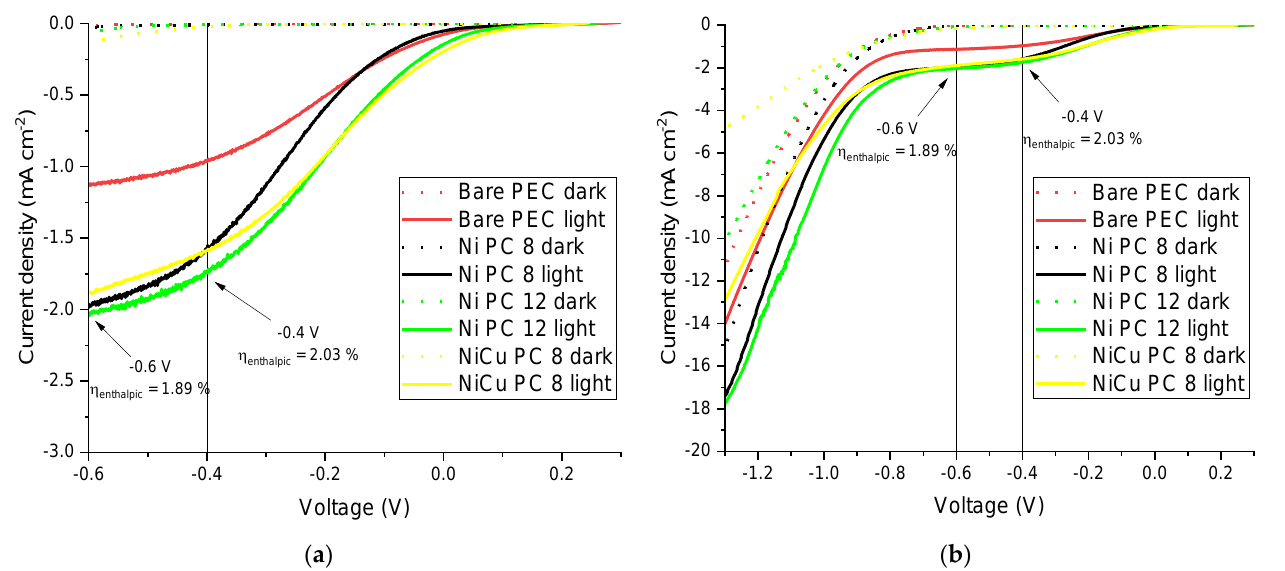
Figure 4. Polarization curves in the dark and under illumination from ( a ) OCP to –0.6 V bias-assisted region and ( b ) from 0.3 to –1.3 V.